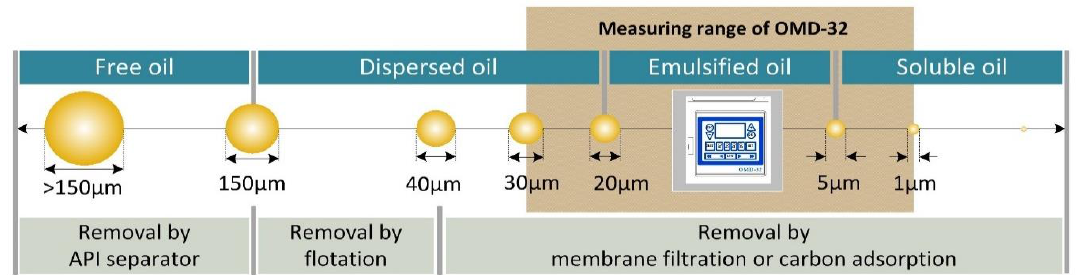
Figure 1. Technologies for the treatment of produced water according to oil droplet size. API = American Petroleum Institute, OMD-32 is an oil-in-water sensor.